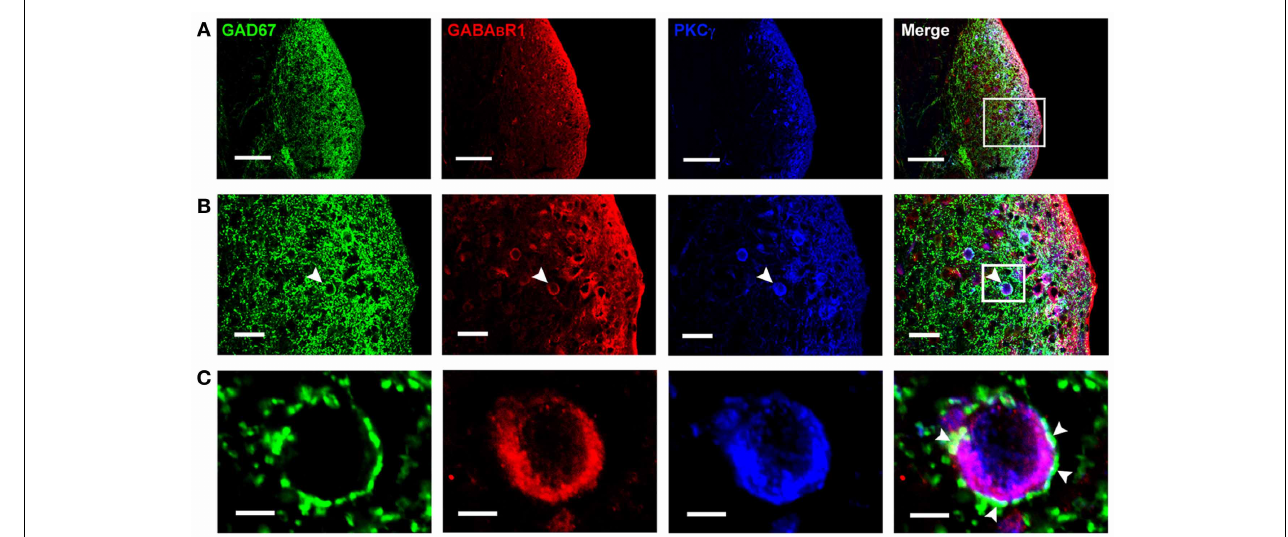
FIGURE 3 | Photomicrographs representing sections of the brainstem of C57 mice in the DCN. Fluorescent images showing the GAD67-positive puncta are distributed densely in the molecular layer and fusiform cell layer of the DCN (A) . In (B) , the arrowheads indicate the triple-labeled neuron for